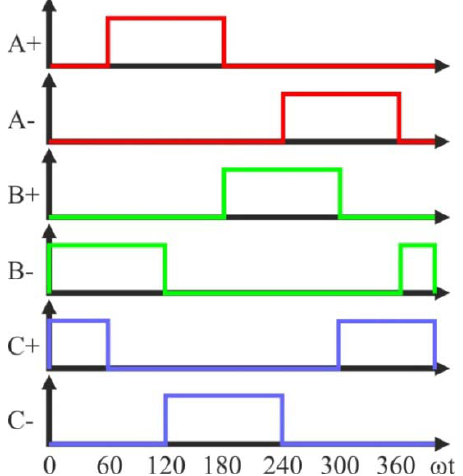
Figure 12. PWM waveforms for a conventional approach